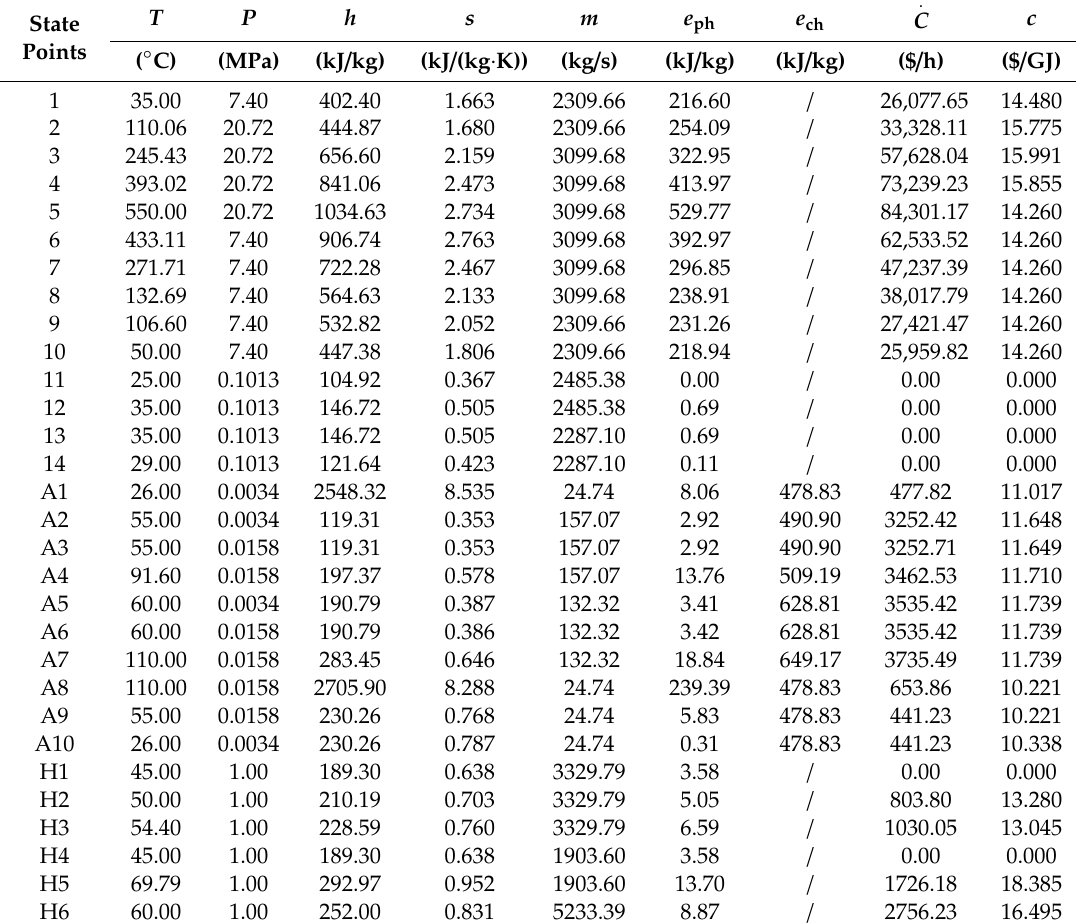
Table 10. Thermodynamic properties and costs of exergy streams for the sCO 2 / LiBr-H 2 O AHP system. State